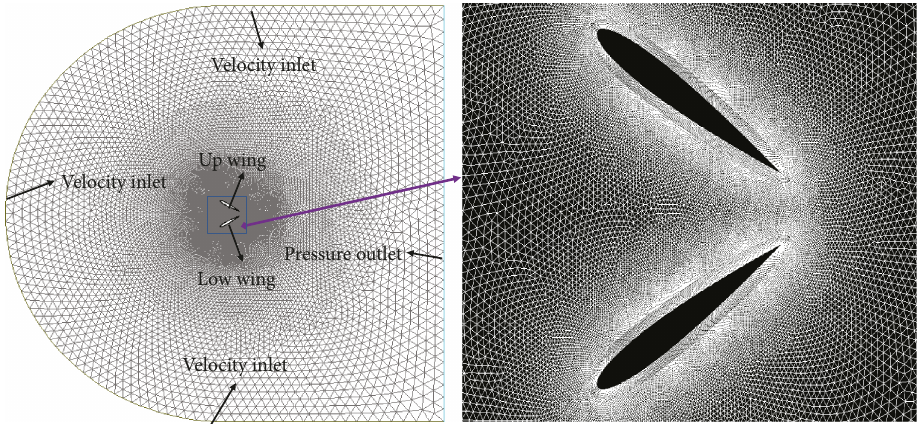
Figure 2: Mesh system of the biplane counter- fl apping